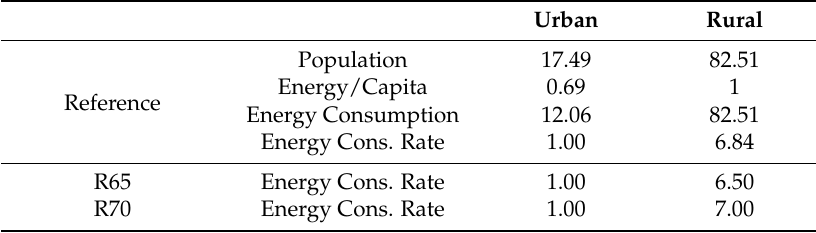
Table 6. Derivation of Energy Consumption Rate Urban vs. Rural and the Sensitivity